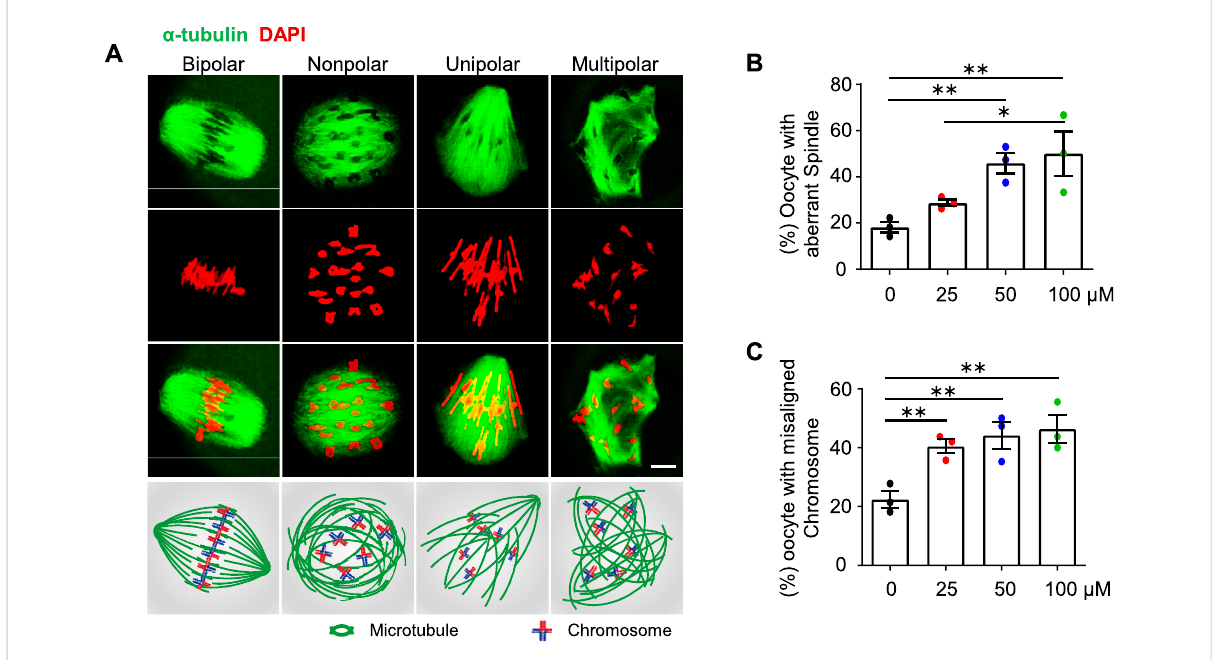
FIGURE 4 AAI exposure causes aberrant spindle organization and misaligned chromosomes in mouse oocytes. (A) GV oocytes were matured in the M16 medium with 0, 25, 50, and 100 μ M AAI for 8 h to reach MI. Representative images showing spindle morphology (green) and chromosome alignment (red) in MI oocytes and corresponding illustration at the bottom row. Normally, homologous chromosomes align on the equatorial plate and spindles from opposite poles ( “ bipolar ” spindles, leftmost) attach to the kinetochore of homologous chromosomes at MI. However, aberrant spindle morphologies ( “ nonpolar ” , “ unipolar ” , and “ multipolar ” spindles) were also observed. Scale bar, 10 μ m. (B,C) Quanti fi cation of oocyteswithaberrantspindles (B) andmisalignedchromosomes (C) in (A) .Errorbar,mean±SEMof3independentexperiments.~20MIoocytesper treatment in each experiment. Totally, 43, 49, 50, and 40 MI oocytes were examined in 0, 25, 50, and 100 μ M AAI treatments, respectively. Only comparisons with signi fi cant differences were indicated; *, p < 0.05; **, p < 0.01; one-way ANOVA and the LSD test (B,C)